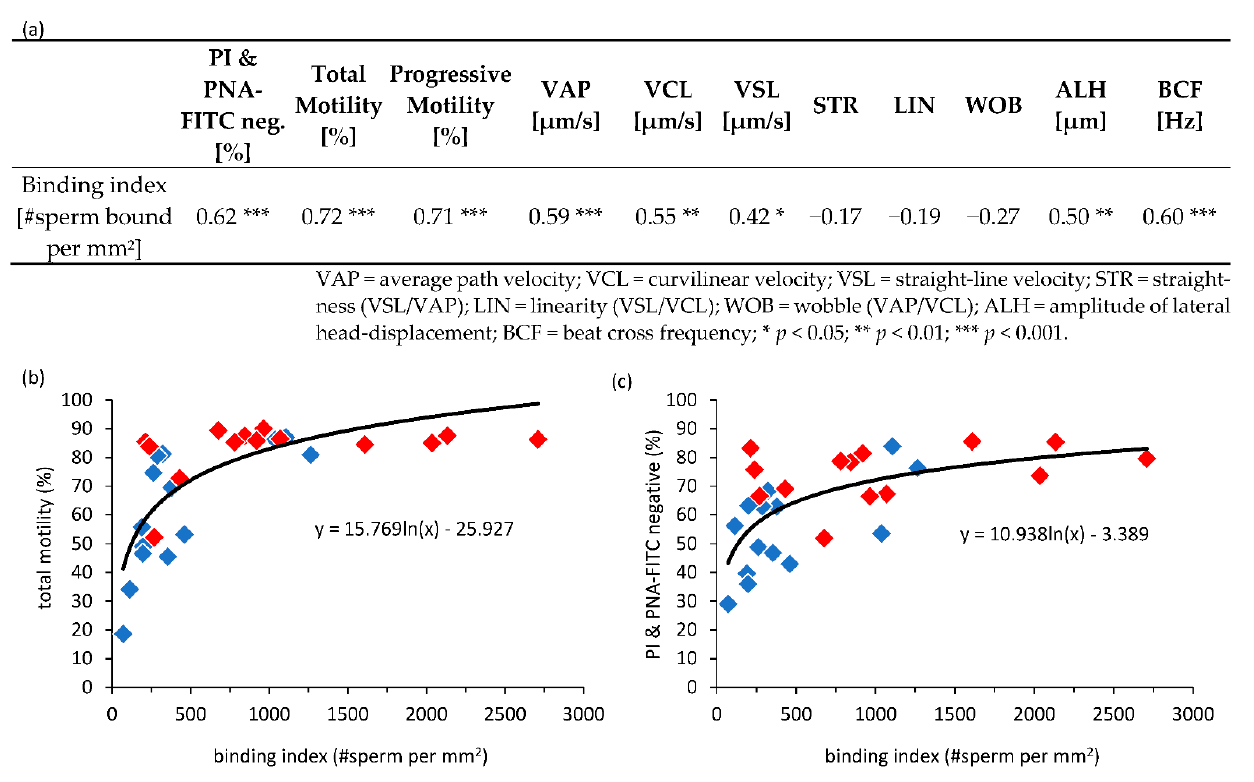
Figure 4. Correlation between semen parameters and sperm oviduct binding of sperm stored for 24 h in either Beltsville Thawing Solution or Androstar ® Plus at 5 °C or 17 °C. ( a ) Spearman correlation coefficients between the number of spermatozoa bound per surface area (binding index), CASA parameters and the number of viable spermatozoa with intact acrosomes (PI & PNA-FITC negative; n = 28 samples). The relation between the binding index and total motility ( b ) as well as the percentage viable spermatozoa with intact acrosomes ( c ) was best modeled by a logarithmic function. Red diamonds represent data from samples stored at 17 °C. Blue diamonds represent data from samples stored at 5 °C.